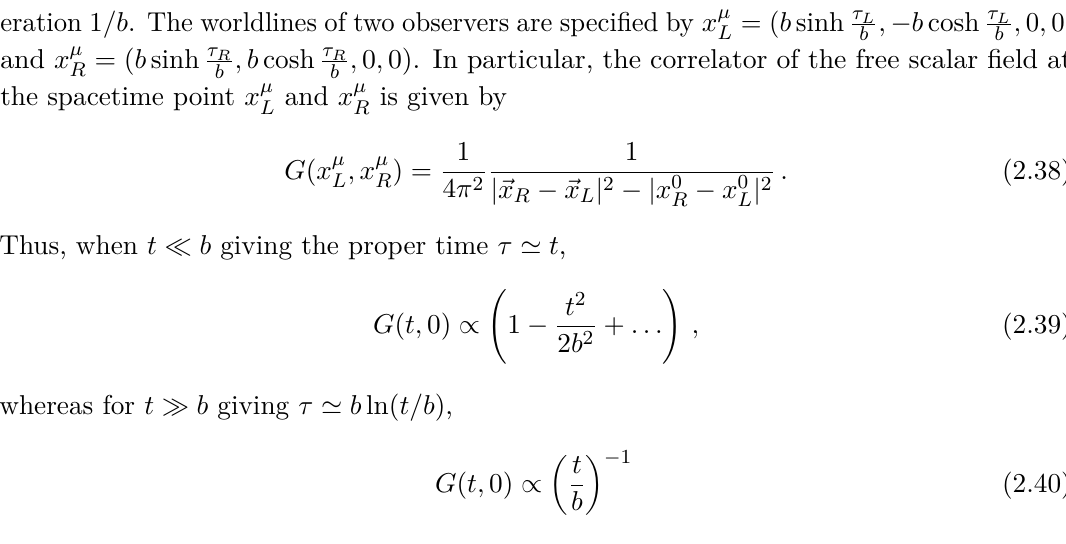
Figure 2 . The time evolution of the G LR ( t, 0) = G RL (0 , t ) correlator. t is in the unit of b and G LR is in the unit of 4 R 2 T 0 i . The curves correspond to the parameters z m q 2 m b 4 1 − z b 2 and 0 . 1 (green),